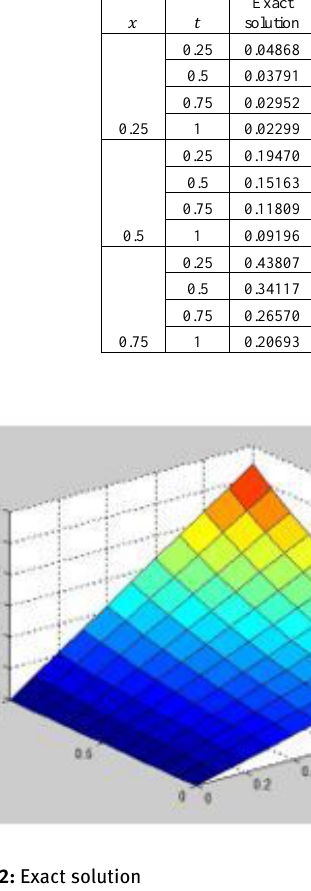
Figure 4: Exact solution